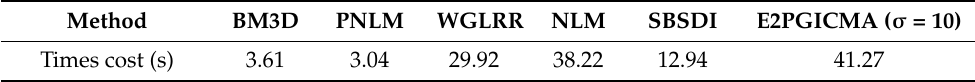
Table 4. Quantitative evaluations of the different noise reduction